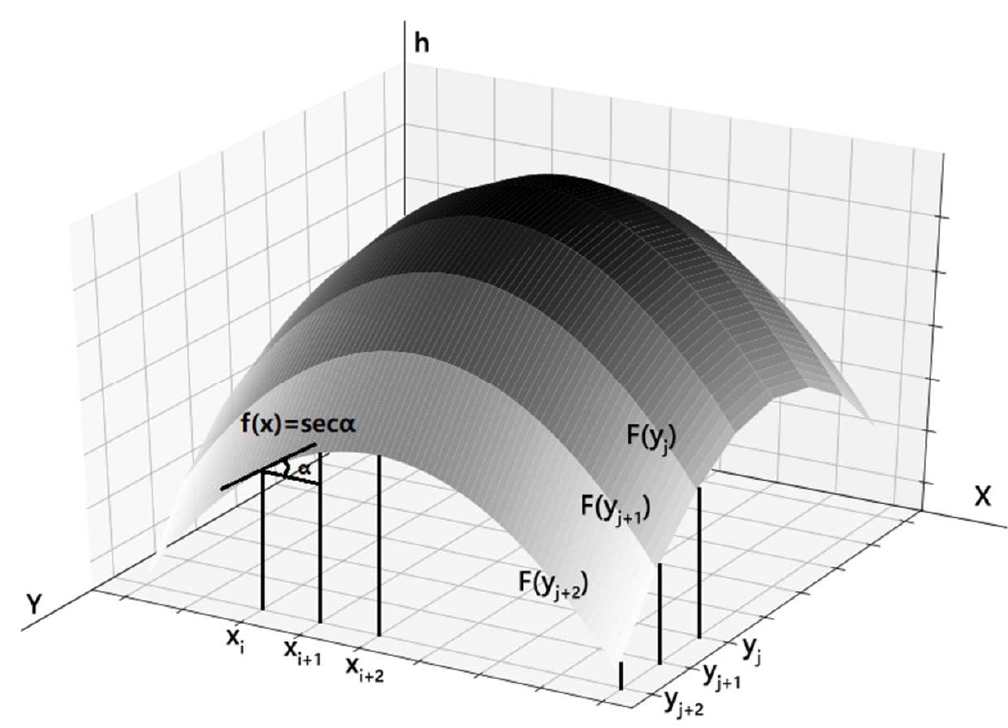
Figure 3. Two-layer approximation of the Simpson-based method.